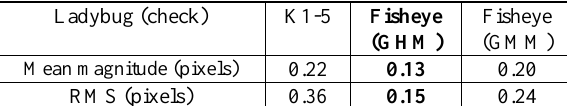
Table 2. Precision on check images of ladybug camera-system in controlled adjustment using the calibration parameters estimated via various calibration models.